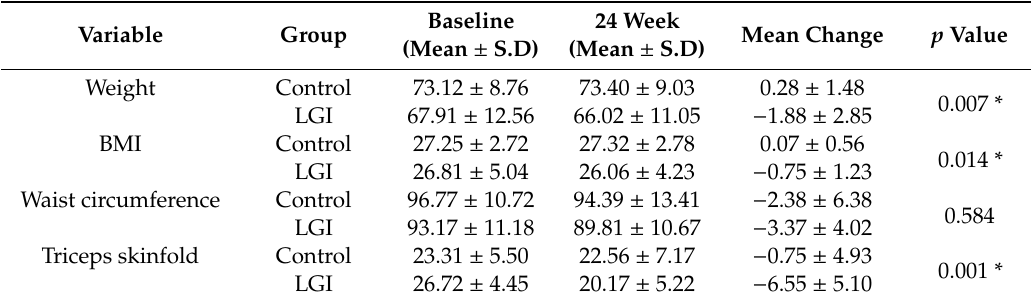
Table 3. Comparison of di ff erences between baseline and 24 weeks in Anthropometric measurements between the LGI and Control